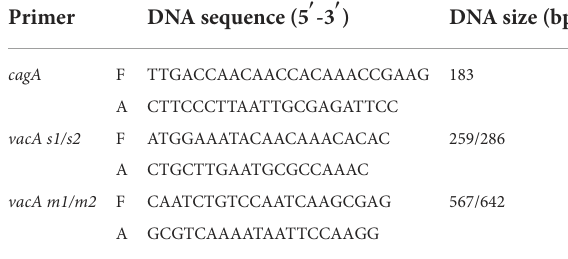
TABLE 1 Primer sequences for virulence